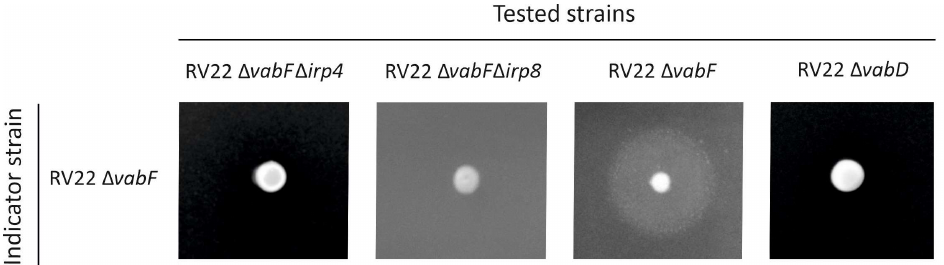
Figure 2. The growth of V. anguillarum parental strain (RV22 Δ vabF ) and its derivative mutants un- der iron excess (10 µM FeCl 3 ) and iron-restrictive (25–75 µM 2,2′-dipyridyl) conditions. Siderophore production was quantified by CAS liquid assay in cell-free supernatants of cultures grown in CM9 supplemented with 25 µM 2,2′-dipyridyl. Uninoculated CM9 with 25 µM 2,2′-dipyridyl was used as blank. Asterisk denotes statistically significant differences, p < 0.05 (student’s t -test).